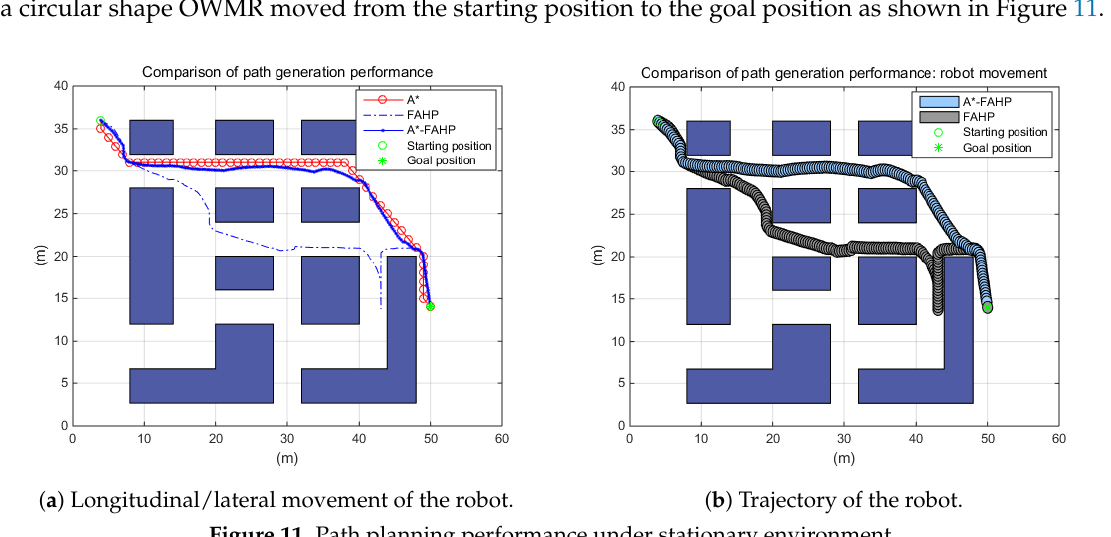
Figure 11. Path planning performance under stationary